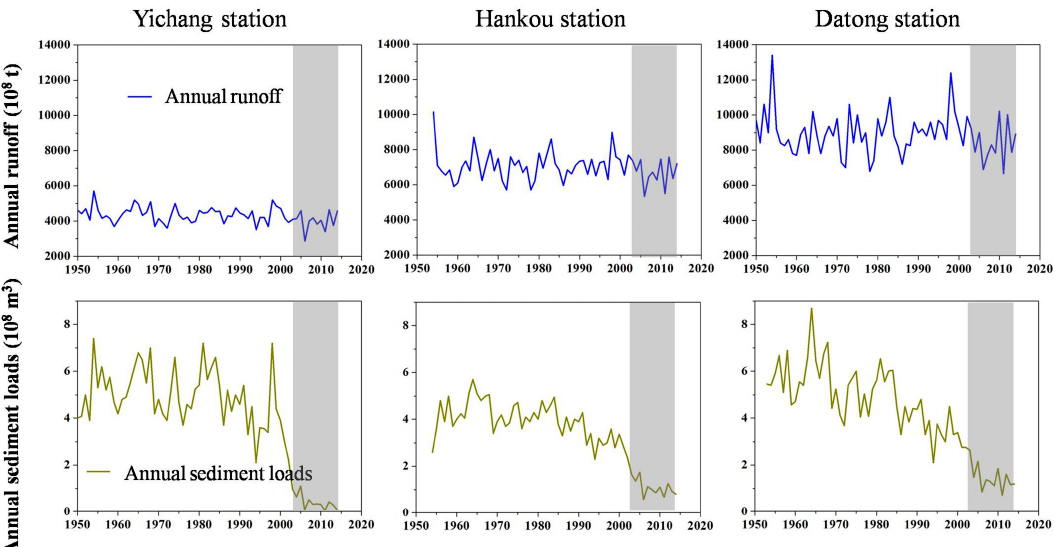
Figure 2. Temporal variations of annual runoff and annual sediment loads at Yichang, Hankou and Datong station (The grey area indicates the post-Three Gorges Dam period).